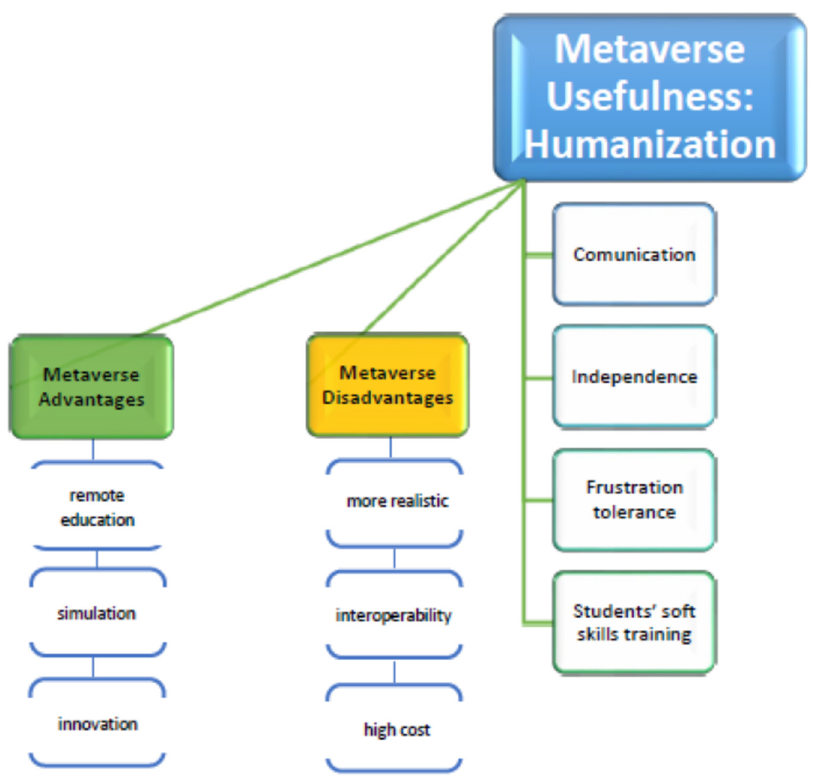
Figure 2. Advantages and disadvantages of Metaverse-related technologies in health education.